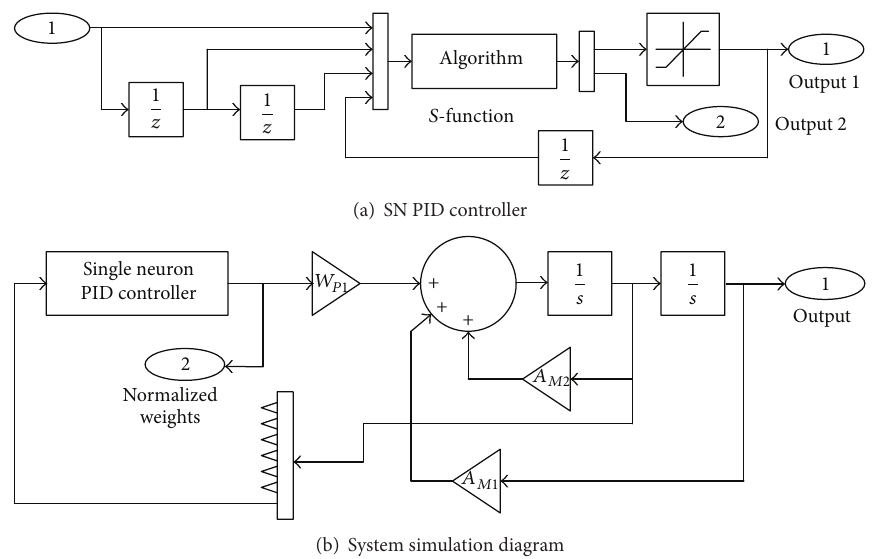
Figure 12: SN PID control block diagram and the system simulation